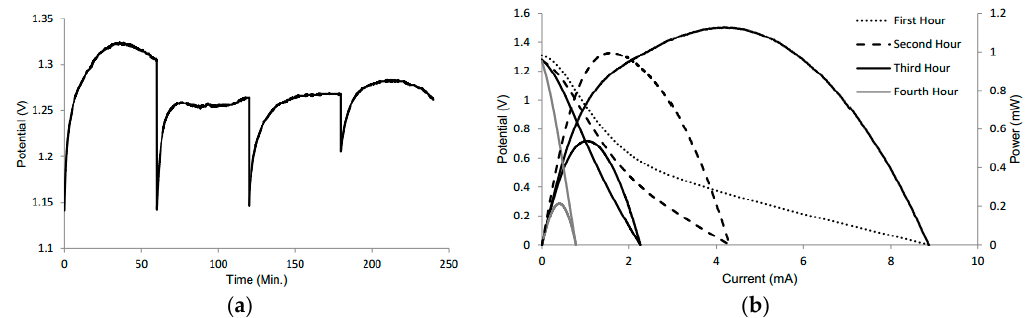
Figure 3. ( a ) Open-circuit voltage plot of the battery tested every hour for four hours with no addition of electrolyte after the initial 15 min. ( b ) Polarization curves of the same battery at every hour. The drop is expected since the VI test demonstrates the maximum amperage of the battery.